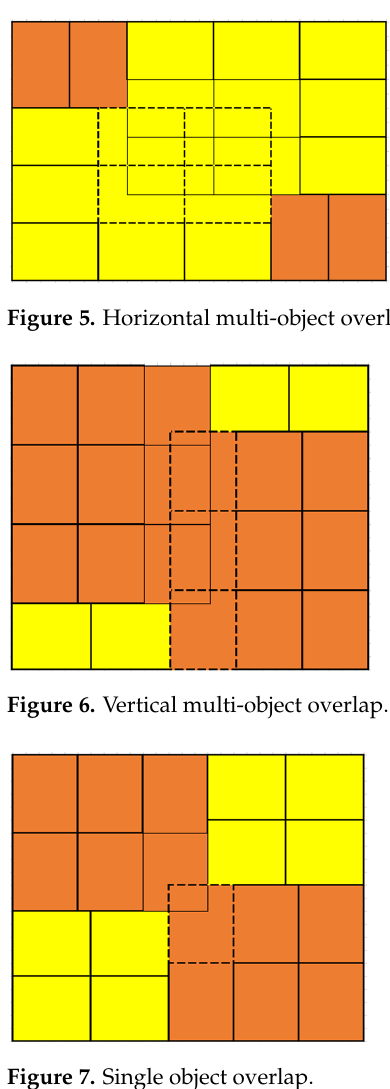
Figure 4. Symmetrical arrangement results. ( a ) Blocks 1 and 3 are bigger than blocks 2 and 4 respectively, and no overlap occurs. ( b ) Blocks 1 and 3 are bigger than blocks 2 and 4 respectively. and overlap occurs. ( c ) Blocks 2 and 4 are bigger than blocks 1 and 3 respectively, and no overlap occurs. ( d ) Blocks 2 and 4 are bigger than blocks 1 and 3 and overlap occurs.